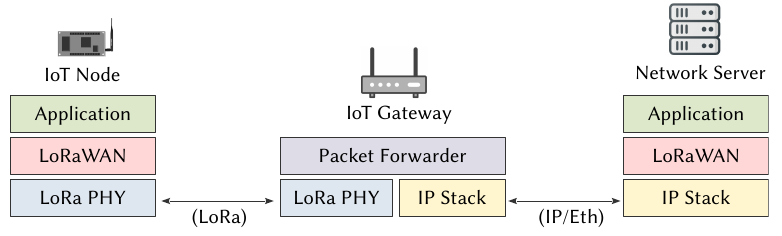
Figure 2. OSI modeling of the LoRaWAN